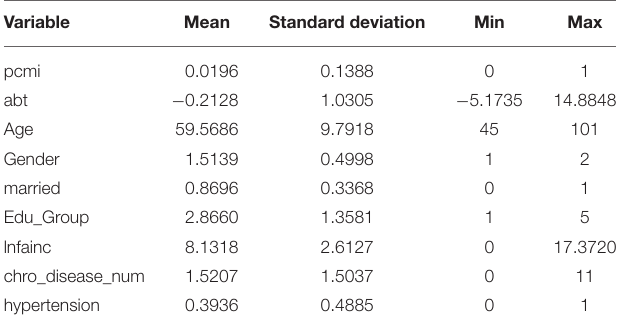
TABLE 1 | Description of variables. TABLE 2 | Descriptive statistical analysis.